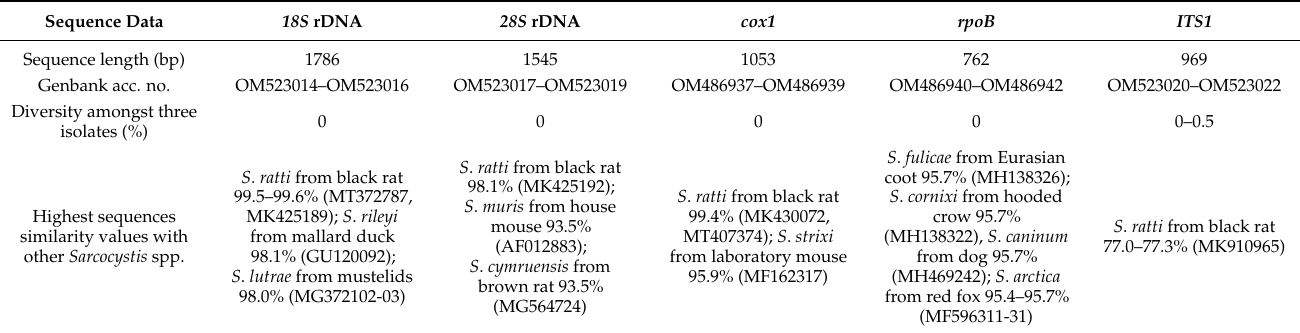
Table 1. Molecular characteristics of Sarcocystis myodes from bank